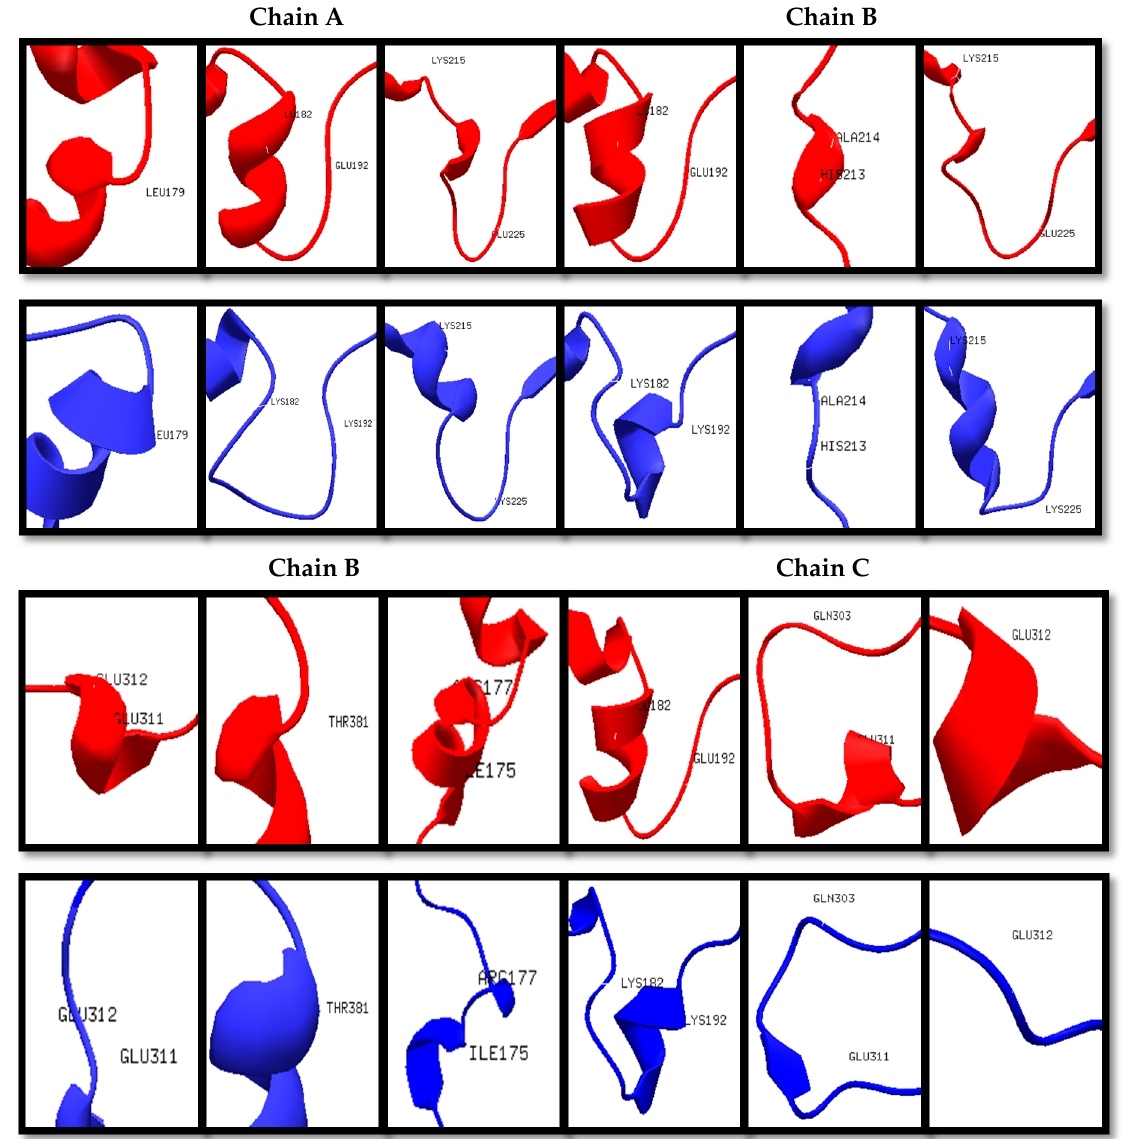
ff erences of specific amino acid residues (red: Wt; blue: Figure 3. Structural differences of specific amino acid residues (red: Wt; blue: Mut234). Figure 3. Structural di